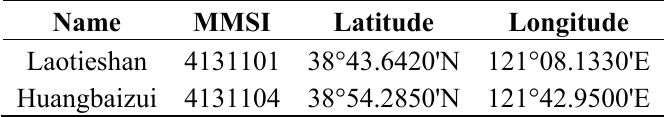
Table 1. Information of the AIS base stations and mobile locations.